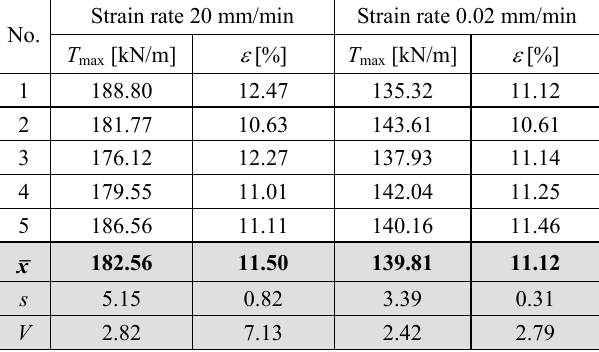
Table 2. Laboratory test